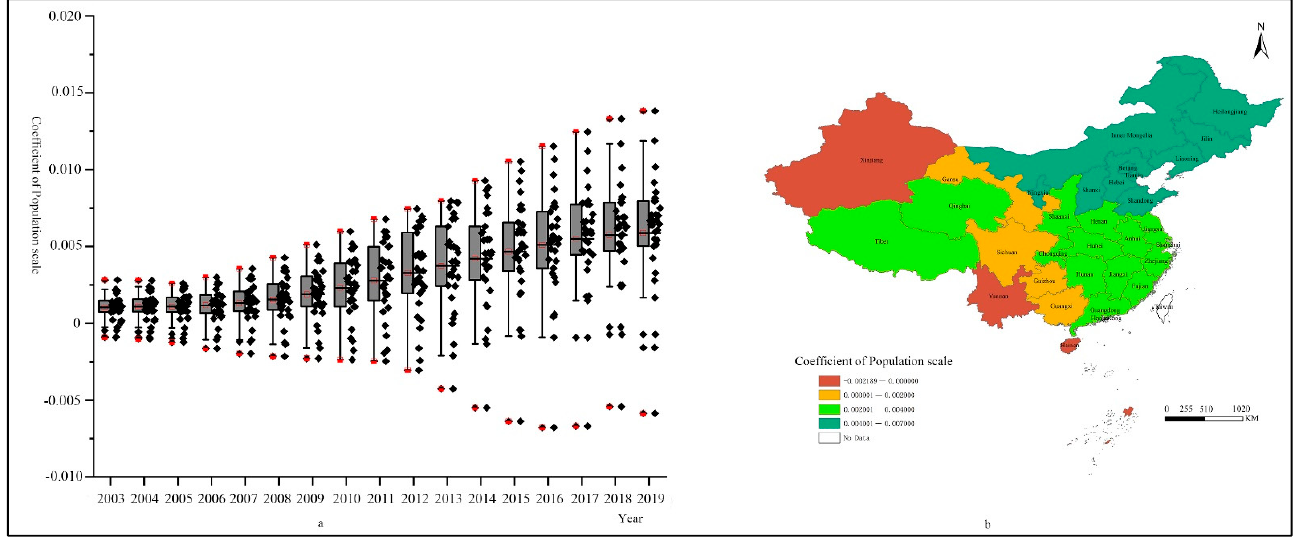
Figure 7. ( a ) Box-plot of regression coefficients of population scale; ( b ) Distribution of mean value of regression coefficients of population scale.